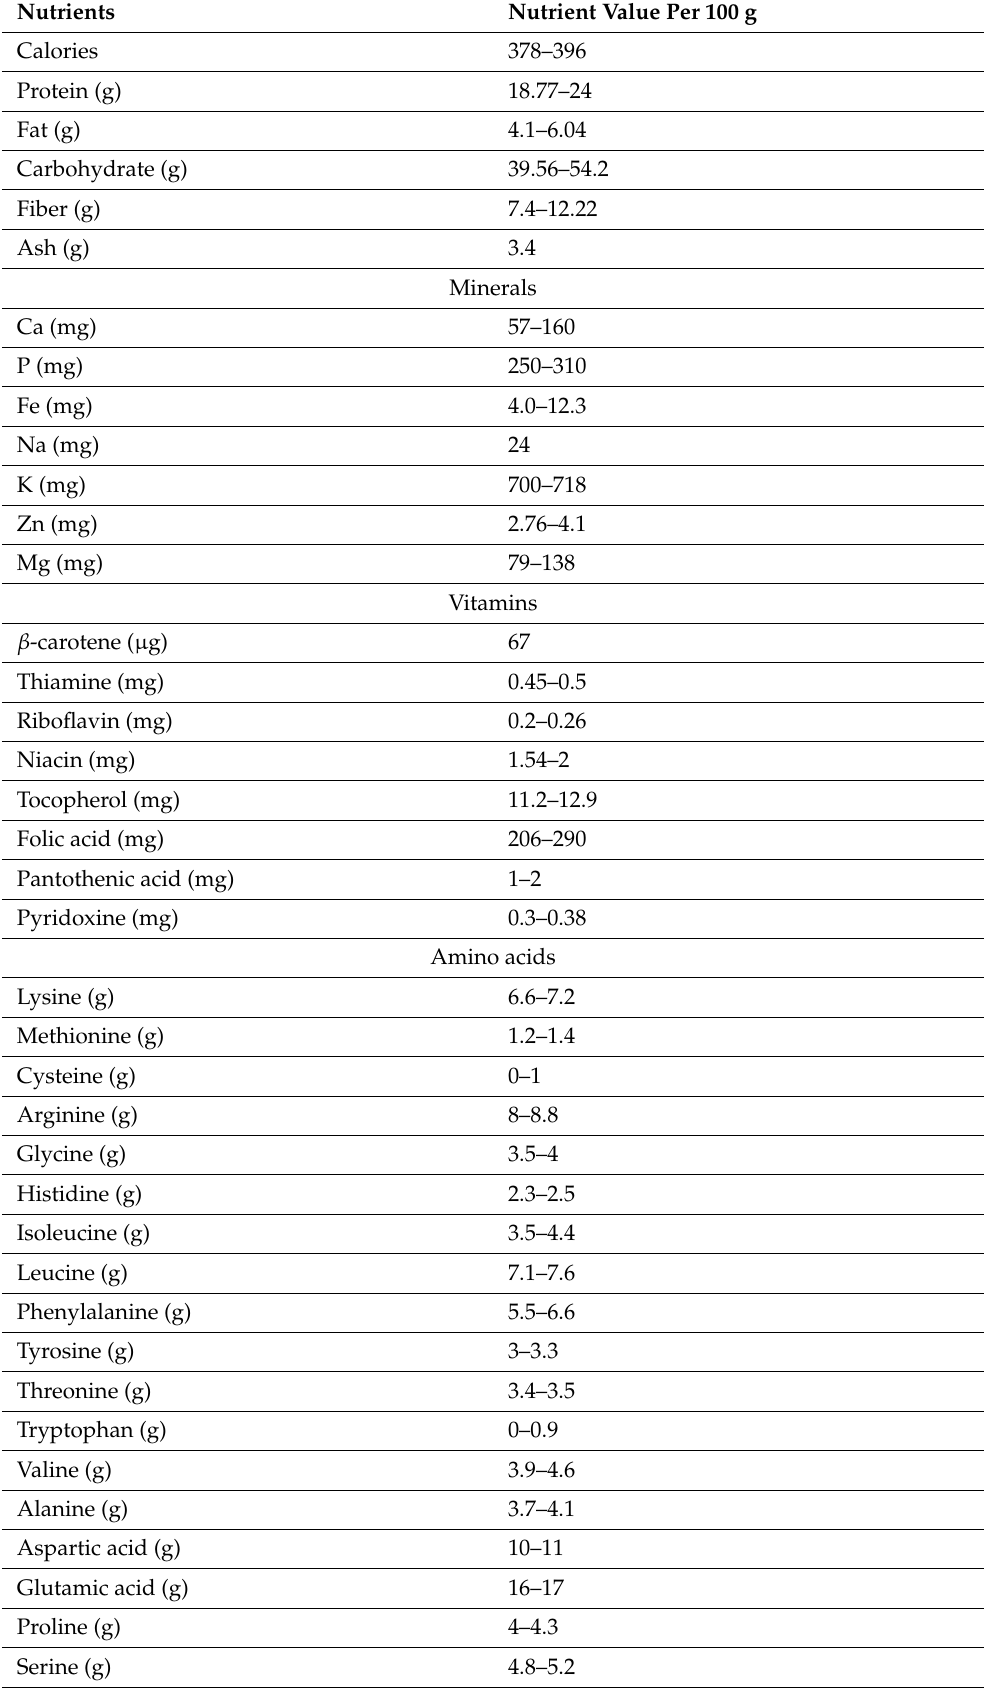
Table 1. Nutrition profile of chickpea ( Cicer arietinum